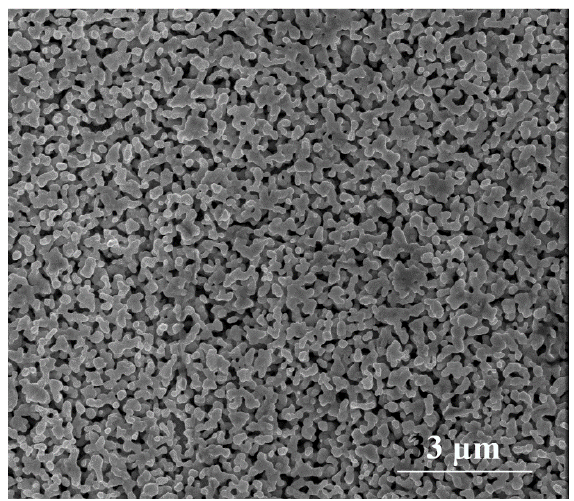
Figure 13. Surface morphology of the silver reference sample.